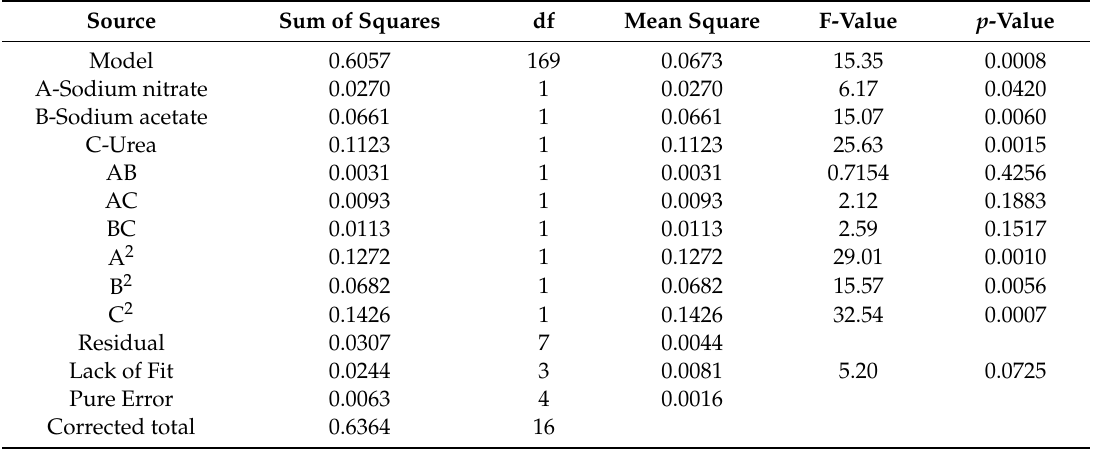
Table 6. ANOVA for the quadratic model of CaCO 3 concentration as precipitated by C. vulgaris